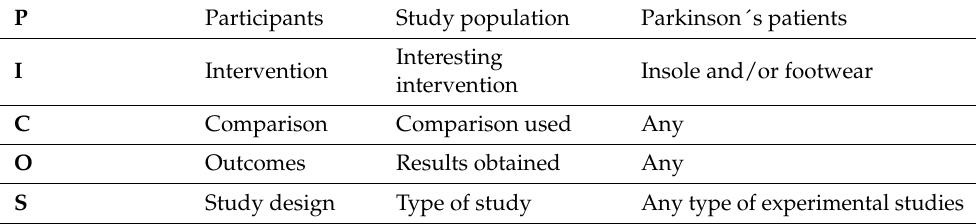
Table 2. Main characteristics of the studies included.